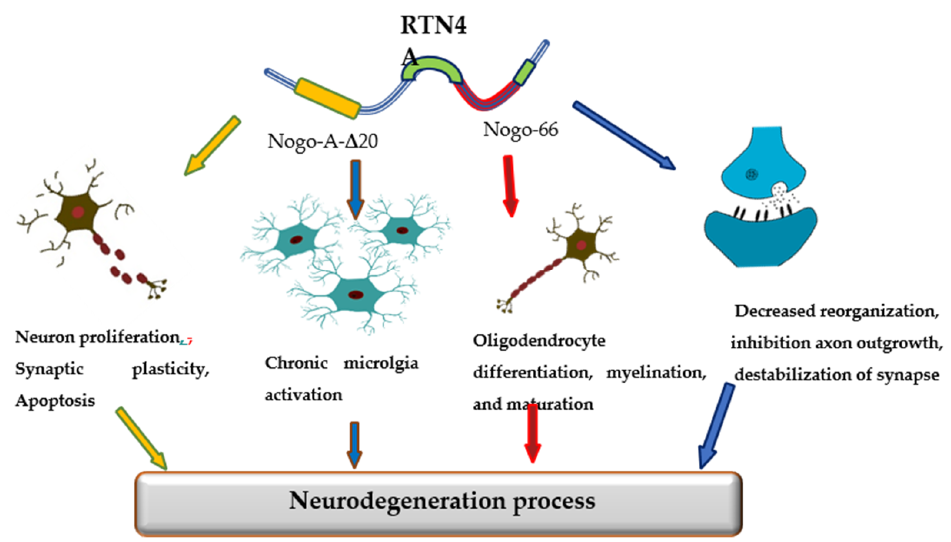
Figure 1. The role of Reticulon 4 (RTN4) in neurodegenerative diseases pathology.